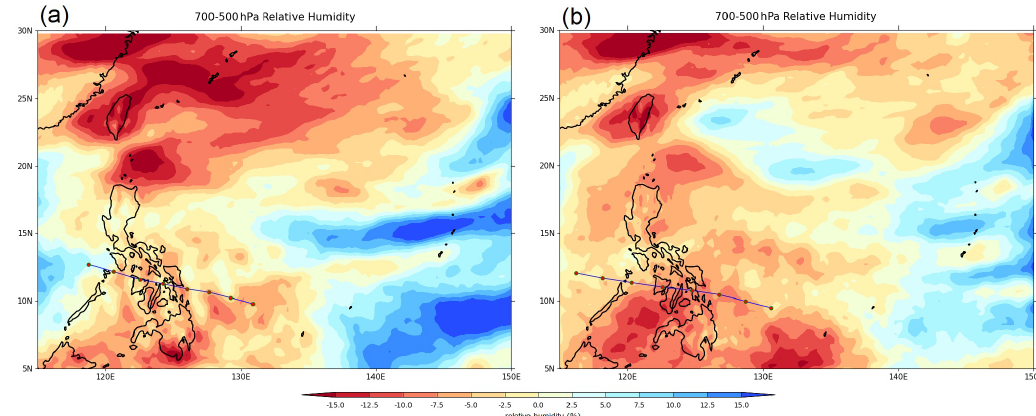
Figure 14. The difference of the simulated mid-tropospheric (700–500hPa) relative humidity averaged over the entire period of the simulation with (a) KF (corresponding to kfsnoffsf1) and (b) TK (corresponding to tksnoffsf1) from ERA5. The 6-hourly WRF output was interpolated to the coarser 6-hourly ERA5 grid using first-order conservative remapping through the CDO remapcon function. The CDO code is available at https://code.mpimet.mpg.de/projects/cdo/ (last access: 13 October